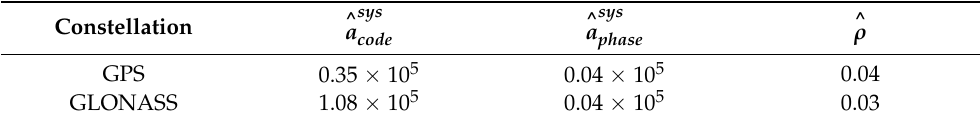
Figure 7. Groupwise estimate of coefficient ( a sys ; sys : GPS and GLONASS and type : code and phase) on L1 frequency as well as correlations among code and phase observations of each constellation (i.e., ρ GPS and ρ GLO ). Table 5. The mean value of the estimated coefficients ( a sys ; sys : GPS and GLONASS and type : code and phase) on L1 frequency as well as the correlation among code and phase observations.